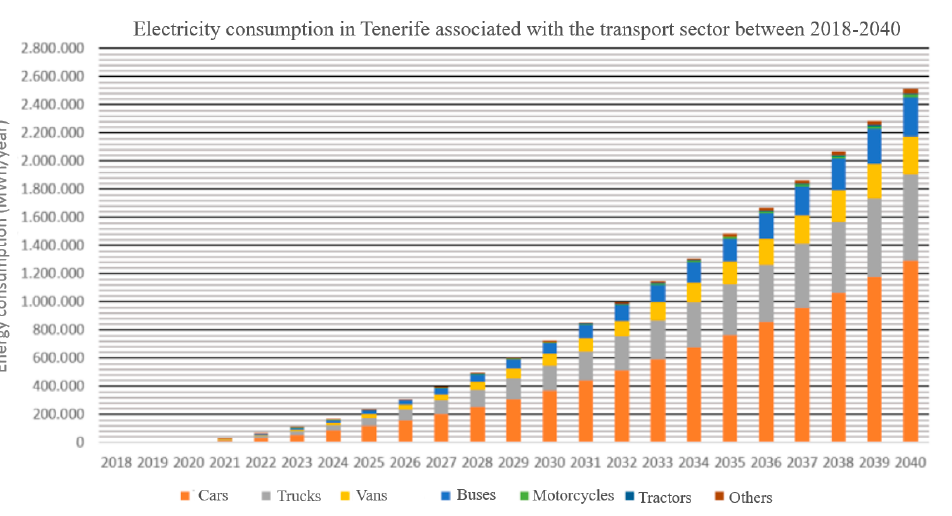
Figure 2. Electricity consumption increase in Tenerife associated with the transport sector between 2018–2040 [6]. 2018–2040